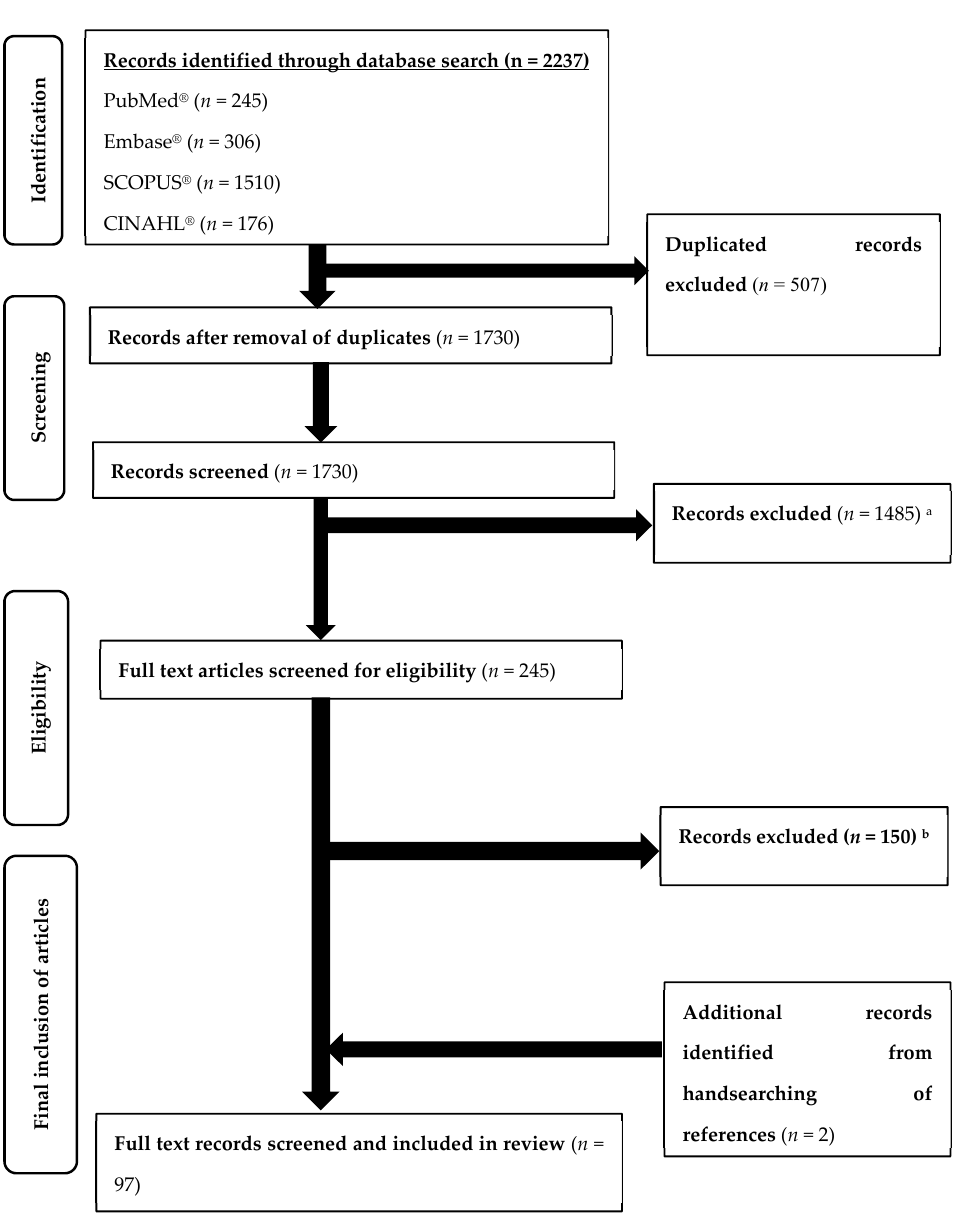
Figure 1. Flowchart for retrieval of articles. a Records excluded: Did not evaluate COVID-19 related vaccine hesitancy ( n = 1425); Evaluated vaccine hesitancy in non-high-income countries ( n = 34); non-English articles ( n = 23); irrelevant systematic reviews/meta-analyses ( n = 3); b Records excluded: Studies included countries other than high-income countries ( n = 14); studies are editorials, commentaries, news article and/or opinions without original data ( n = 132); Study looked at willingness of guardians enrolling children in vaccine trials ( n = 1); studies retracted ( n = 3)